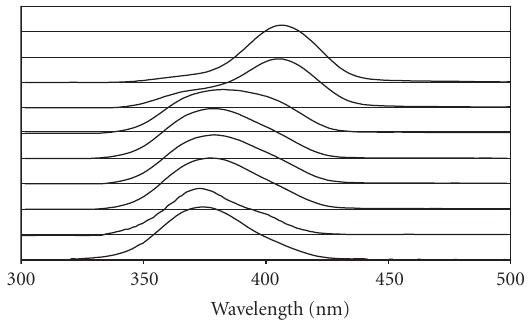
Table 3: The band gap energies of A11 and P25 samples.